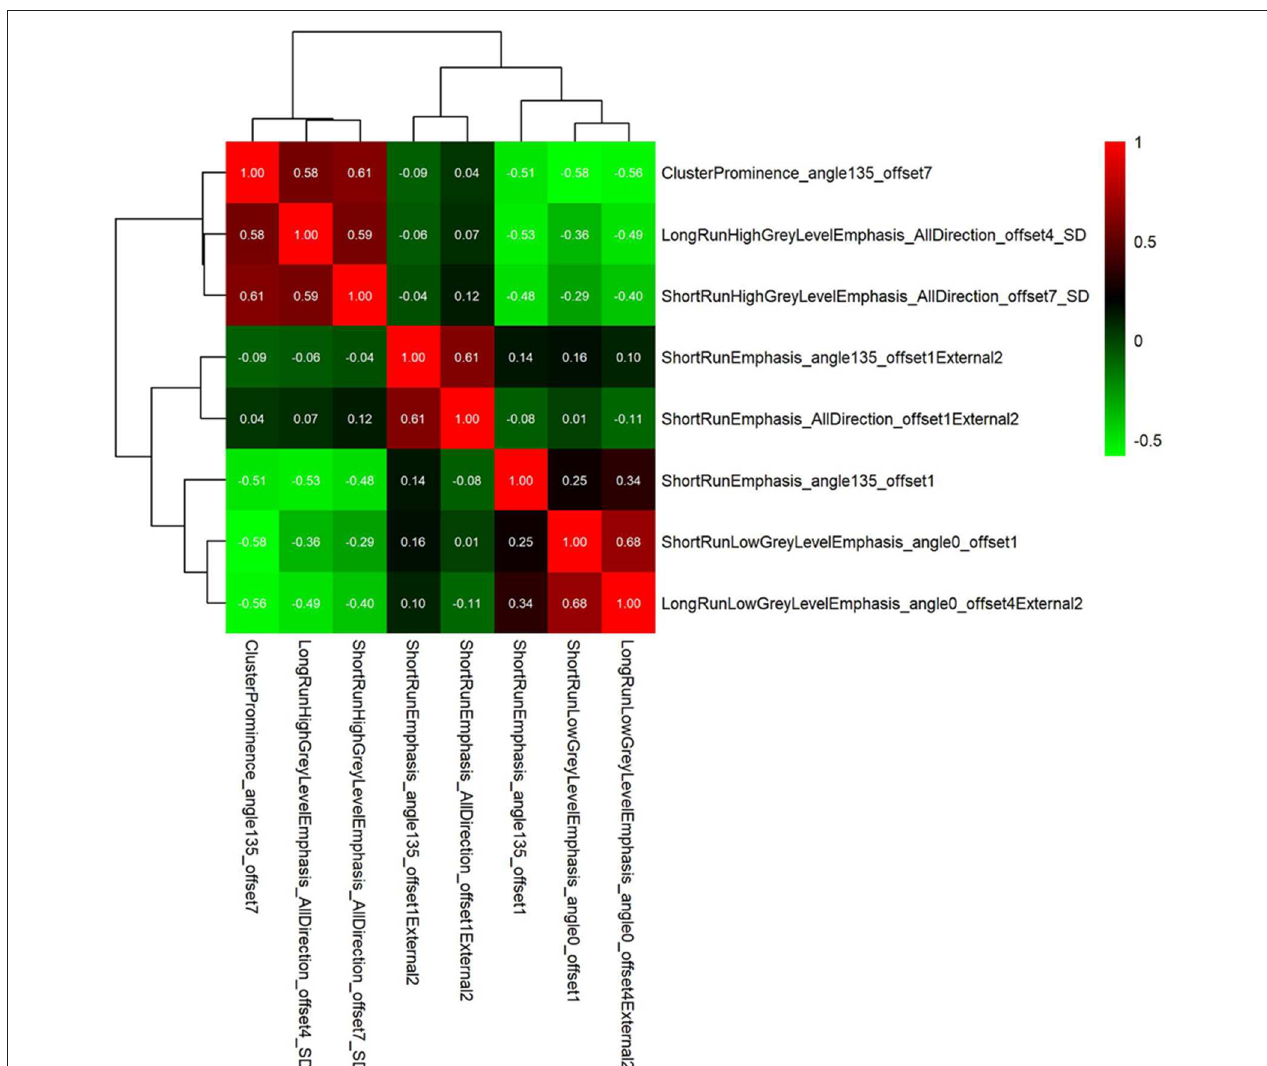
FIGURE 5 | The correlation matrix heat map showing no collinearity between the gross